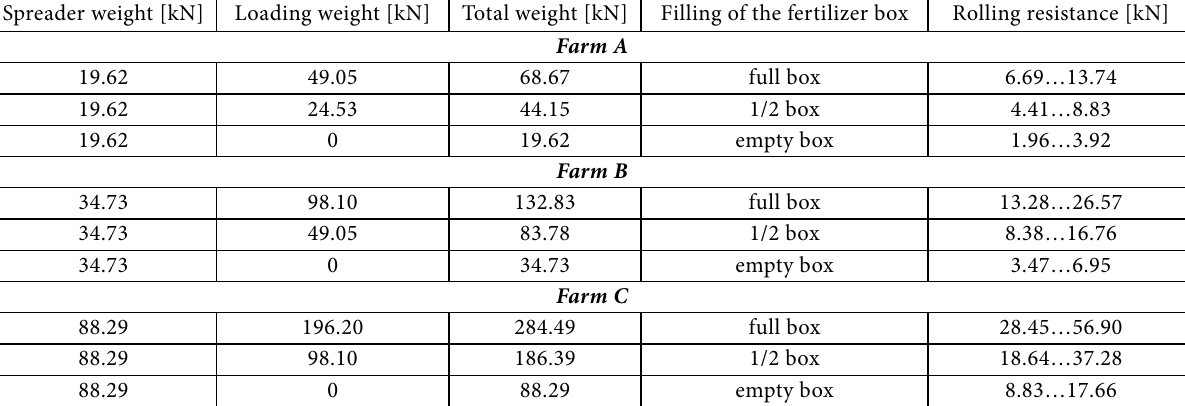
Spreader weight